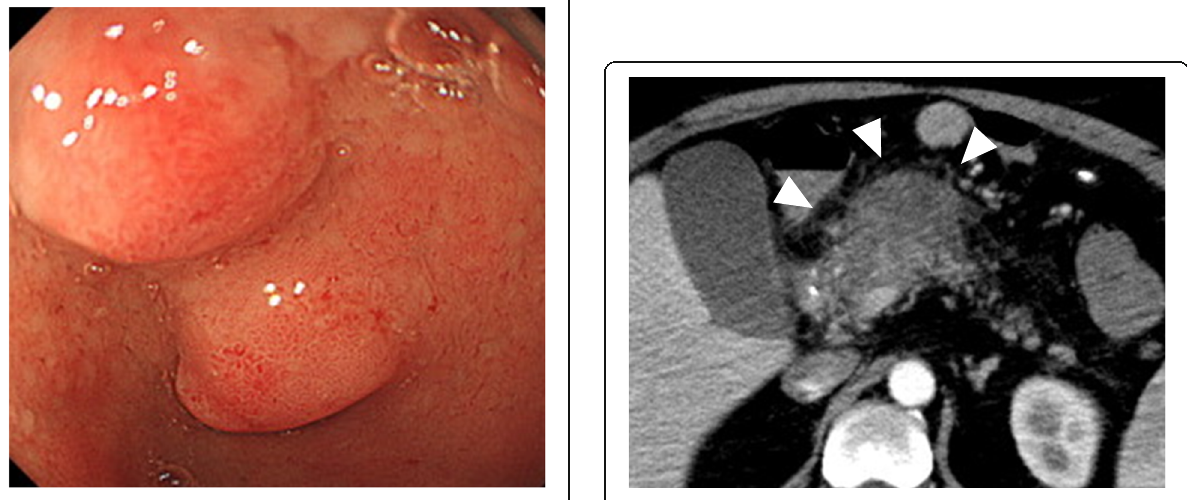
Fig. 1 Esophagogastroduodenoscopy (EGD) findings. EGD showing two smooth elevated lesions with a diameter of 10 mm in the anterior wall of the duodenal bulb